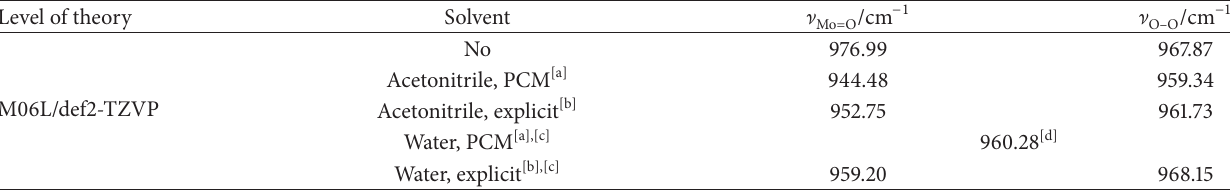
Table 12: Calculated Mo=O and O–O stretching frequencies in gas phase, with explicit solvation and with implicit solvation via PCM. Level of